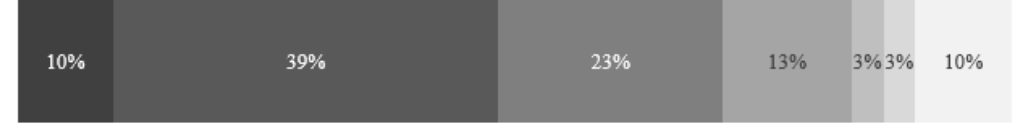
Figure 1: Group 1 student ratings of information on Twitter feed interesting Students positively engaged with the content of the tweets. As can be seen it Figure 1, 71% (n=22) of respondents agreed that the information being retweeted was interesting. 48% (n=15) of students agreed that the information presented through the newsfeed was helpful in their understanding of a particular topic. Similarly, 48% (n=15) of respondents agreed that they have followed suggested links to additional